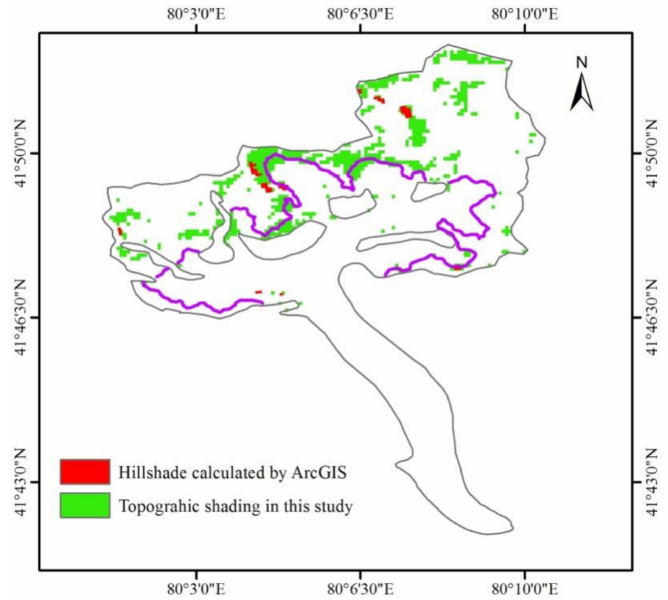
Figure 12. Comparison of topographic shading calculated by AcrGIS and this